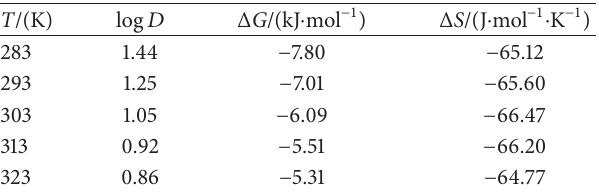
Figure 4: Effect of temperature on Te(IV) extraction. Table 4: Values of Δ𝐺 and Δ𝑆 of the extraction process at different temperatures.